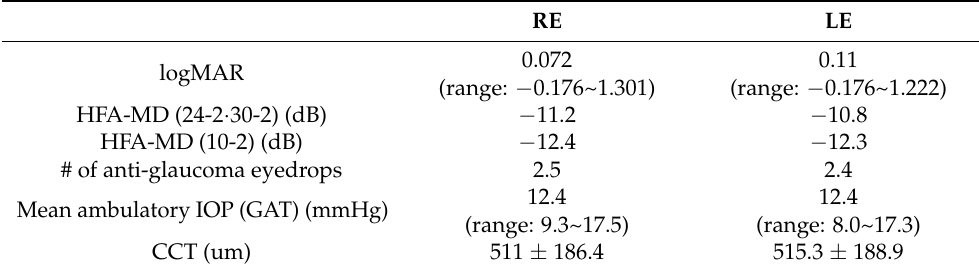
Table 1. Demographics of enrolled patients.